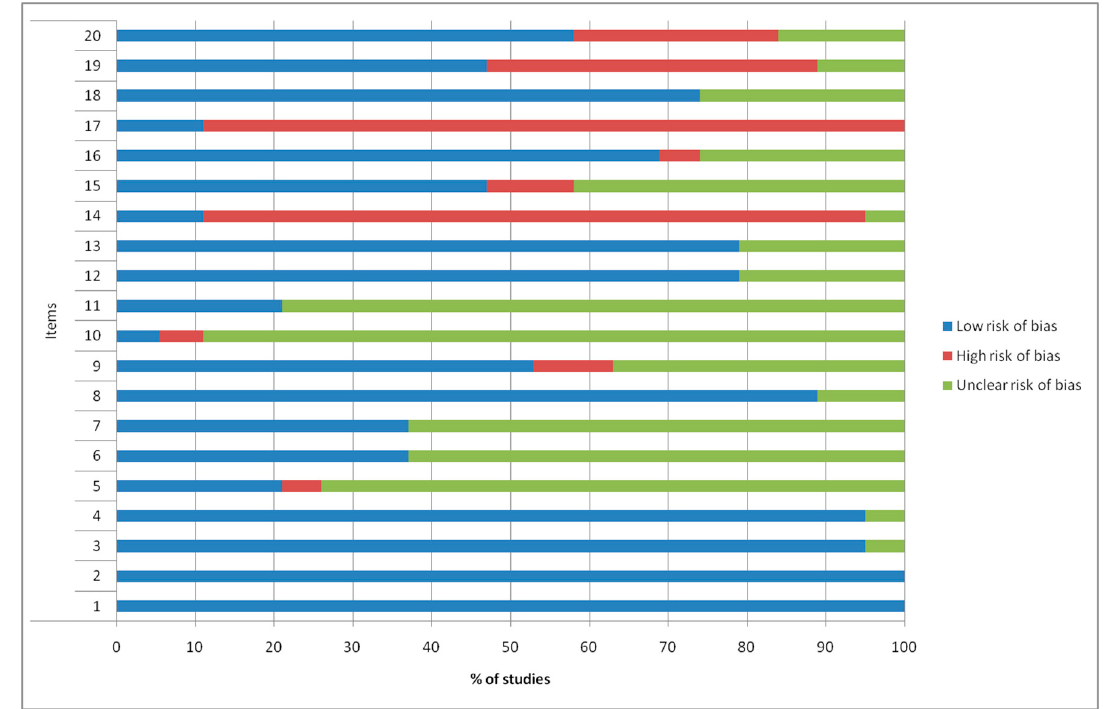
Figure 2. Frequencies (%) of quality assessment according to Animal Research Reporting In Vivo Experiment (ARRIVE) criteria. Int. J. Mol. Sci. 2020 , 21 , 3696